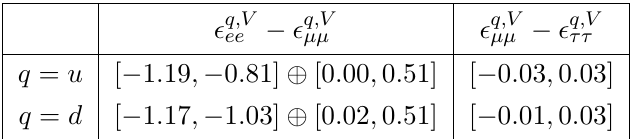
Table 1 . Limits at 90% C.L. on NSI from a global (cid:12)t to neutrino oscillation data while